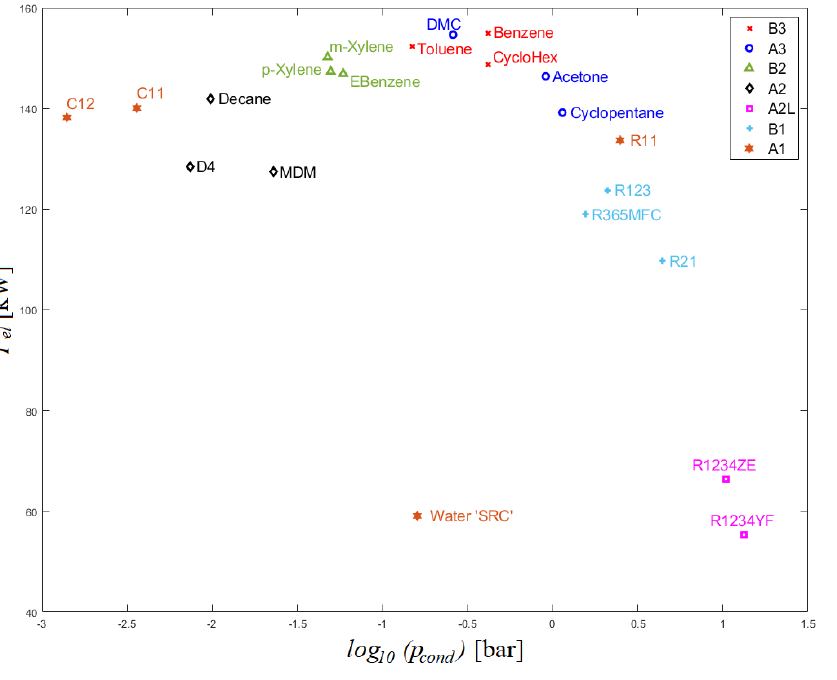
Figure 9. Net output power versus condensation pressure (in logarithmic scale) of the best 3 fluids of each safety category in the case of oil thermal